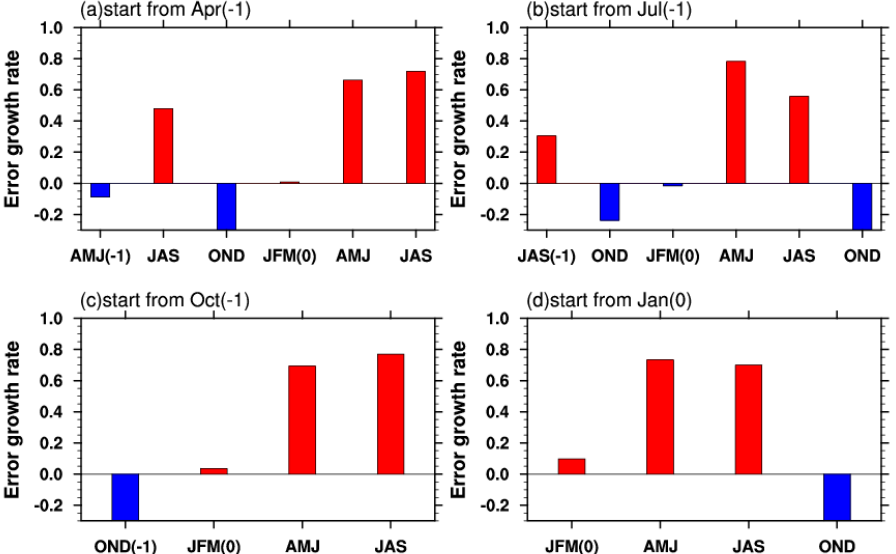
Figure 2. The ensemble mean of seasonal error growth rate for pIOD predictions (histograms) with − 1), ( b ) July ( − 1), ( c ) October ( − 1) and ( d ) January the start month being: ( a ) April (-1), ( b ) July (-1), ( c ) October (-1) and ( d ) January (0). the start month being: ( a ) April (